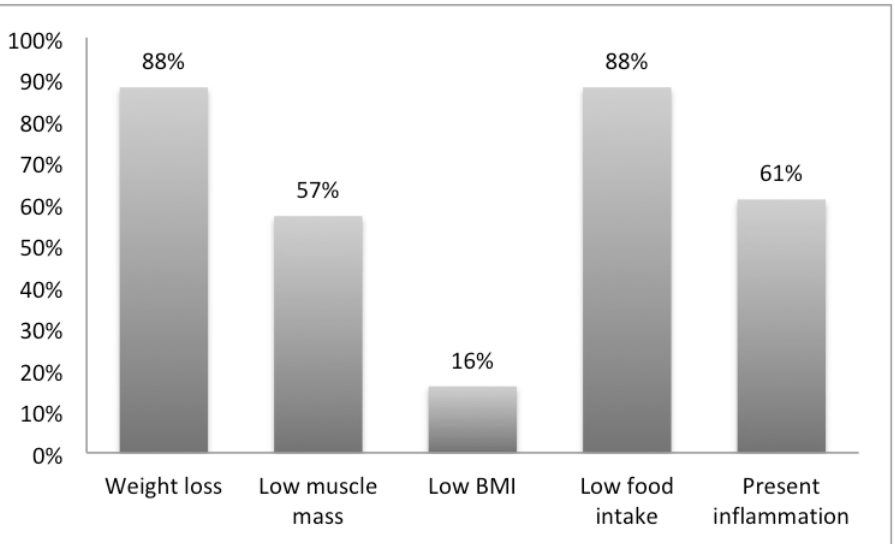
Figure 3. Frequencies of the phenotypic and etiologic criteria present in the malnourished patients as classified by the Global Leadership Initiative on Malnutrition (GLIM) (n = 122).